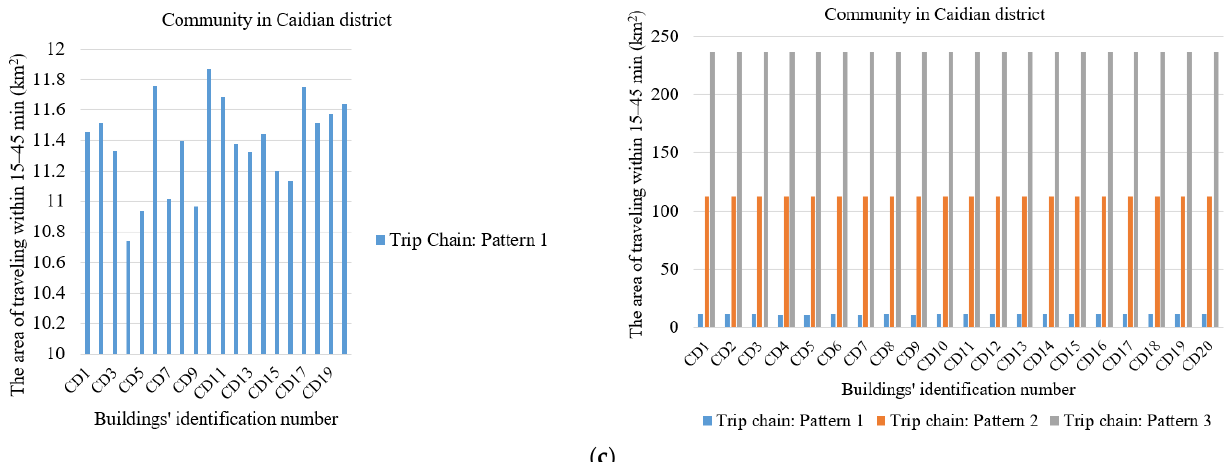
Figure 7. Statistics of the reachable area by taking different patterns of trip pattern, ( a ) community in Wuchang district; ( b ) community in Jiangan district; ( c ) community in Caidian district.